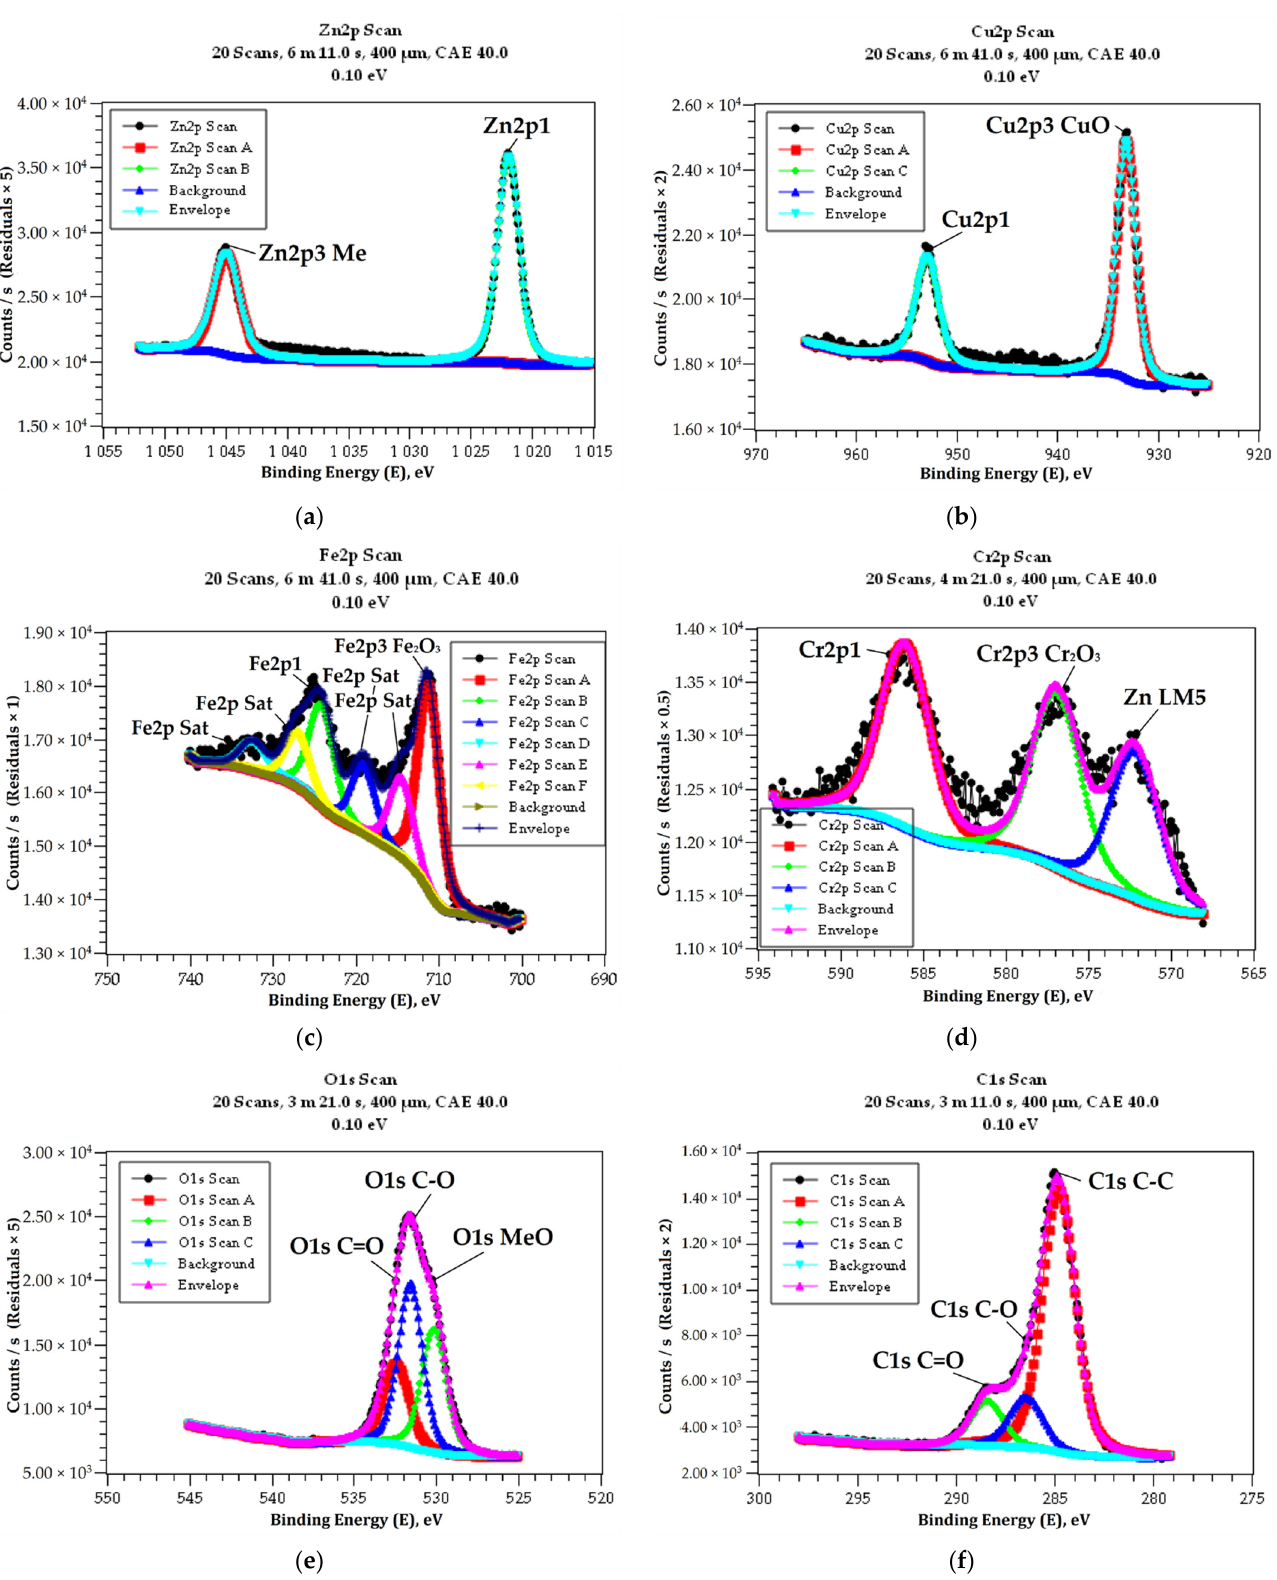
Figure 8. X-ray photoelectron spectroscopy of X10CrNiTi18-10 (12kH18N10T) steel specimens after wire electrical discharge machining with a brass tool electrode in water medium: ( a ) zinc; ( b ) copper; ( c ) iron; ( d ) chromium; ( e ) oxygen; ( f ) carbon.